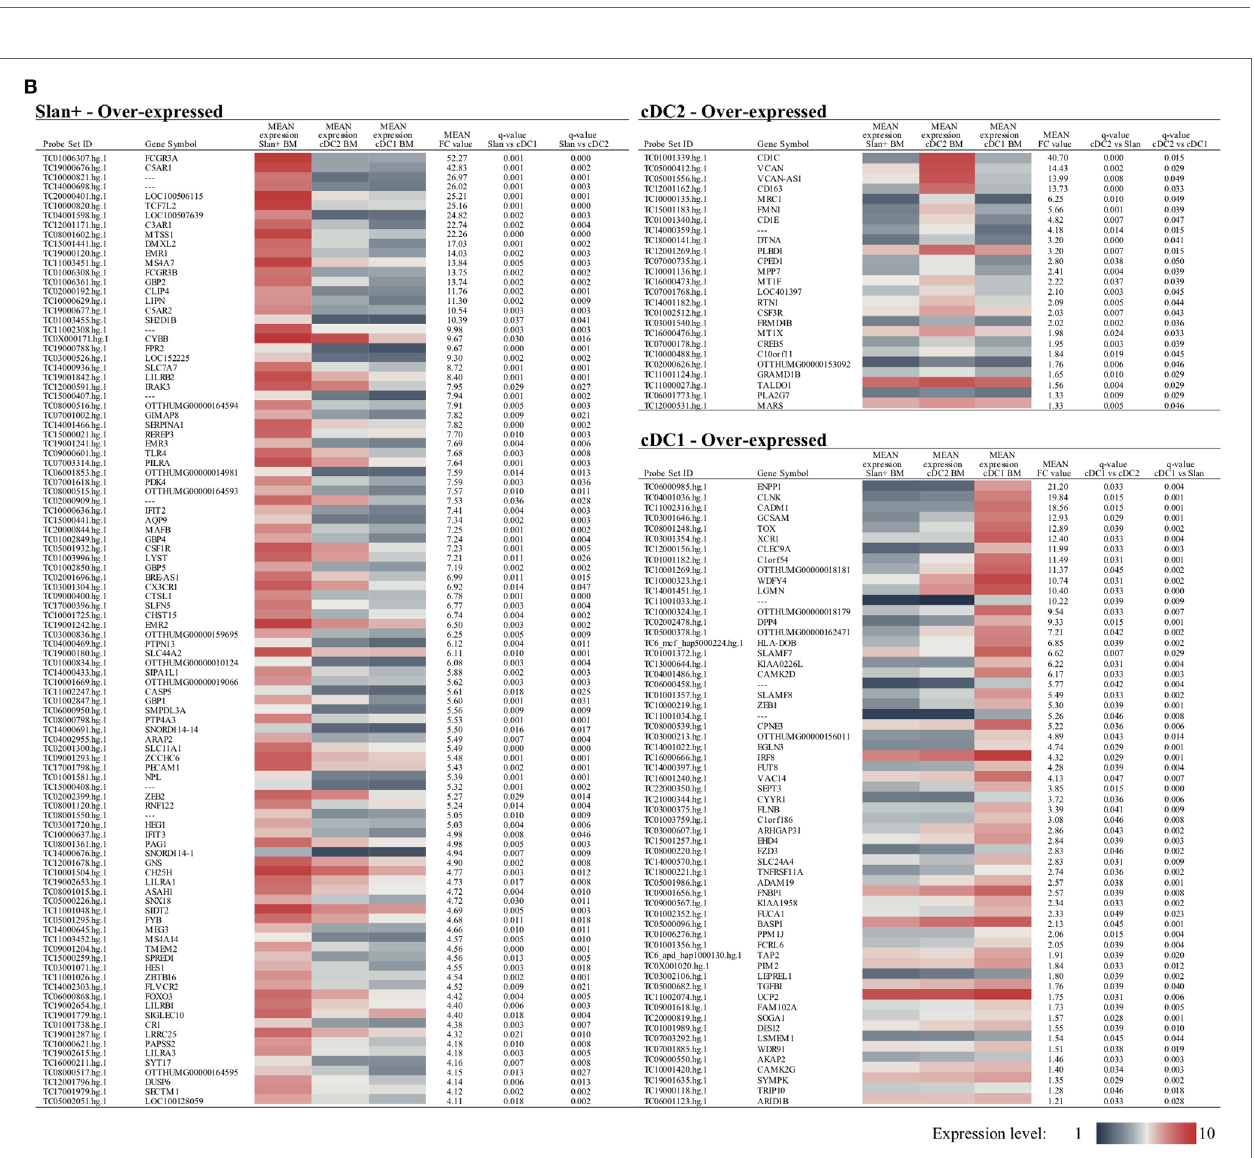
FigUre 3 | Differentially expressed genes (DEGs) between slan + monocytes and cDC2 and cDC1 in the bone marrow (BM) compartment. After identification, DEGs were further analyzed for the three cell subsets in the BM compartment. (a) Cluster analysis of transcripts that are differentially expressed between the subsets are presented in a heat map. Each row represents a single transcript. Relative expression levels for four donors per subset are shown. z -scores were calculated in one row to show the relative expression values per donor compared to the mean of the entire row ( z -score − 2: low expression, z -score + 2: high expression). Four different clusters were generated. In green, DEGs that were over-expressed in cDC2 are shown, whereas DEGs over-expressed in cDC1 are within the blue cluster. Under- and over-expressed transcripts for slan + monocytes are shown in yellow and gray, respectively. (B) Coding and over-expressed transcripts, sorted on mean FC values, are shown for all cell subsets. For slan + monocytes the top 100 is used, whereas for the other two cell subsets 25 and 60 transcripts are shown (cDC2 and cDC1, respectively). For each transcript, the mean absolute expression level of four donors (1: low expression, 10: high expression) is color coded in the given cell subset. Q-values for both comparisons (i.e., slan + vs cDC2 and slan + vs cDC1) are shown. (c) Pathway analysis of over-expressed transcripts in slan + monocytes compared to both DC subsets. The top 100 highest FC values from over-expressed coding transcripts were imported into the STRING v10.0 bioinformatics tool and significant enriched pathways were identified. From this list, the top 10 with lowest FDR (out of 62) of enriched biological processes are shown. (D) Enriched KEGG pathways for over- and under-expressed transcripts in slan + monocytes compared to DC subsets. Top 100 highest FC values of coding transcripts were used from the over- and under-expressed gene lists. An interaction network analysis of involved transcripts is displayed for over-expressed genes (e) as well as for under-expressed genes (F) in slan + monocytes. Disconnected nodes are hidden and the line thickness indicates the strength of data support. Abbreviations: FC, fold change; FDR, false discovery rate; GO, gene ontology; ID, identification; KEGG, Kyoto encyclopedia of genes and